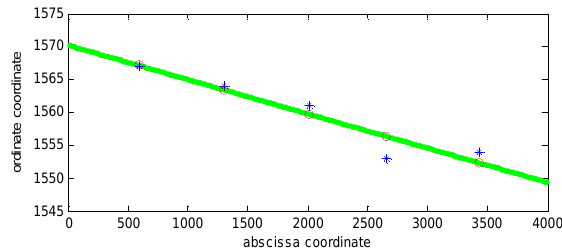
Figure 2. The estimated results of the image coordinates for the given laserscanning line: 5 measured supporting points (blue stars), 5 fitted supporting points (red circles), and values in between for representing each laserscanning measurement (green